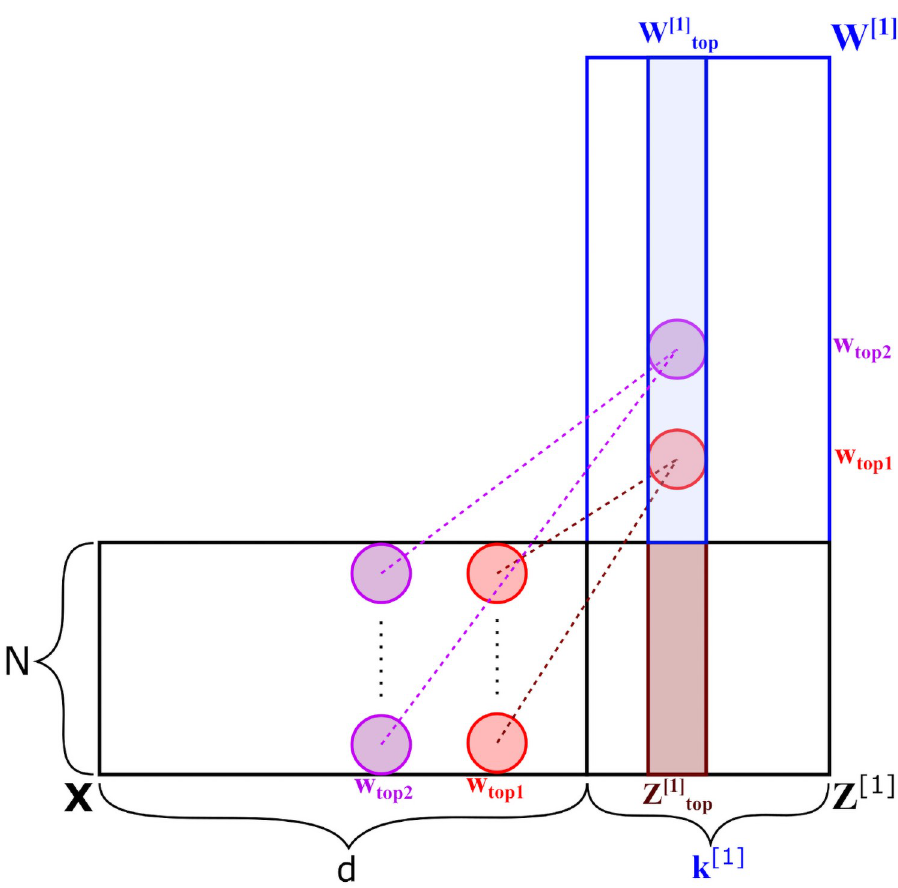
Fig 10. Selection of relevant input variables, by reverse-engineering matrix